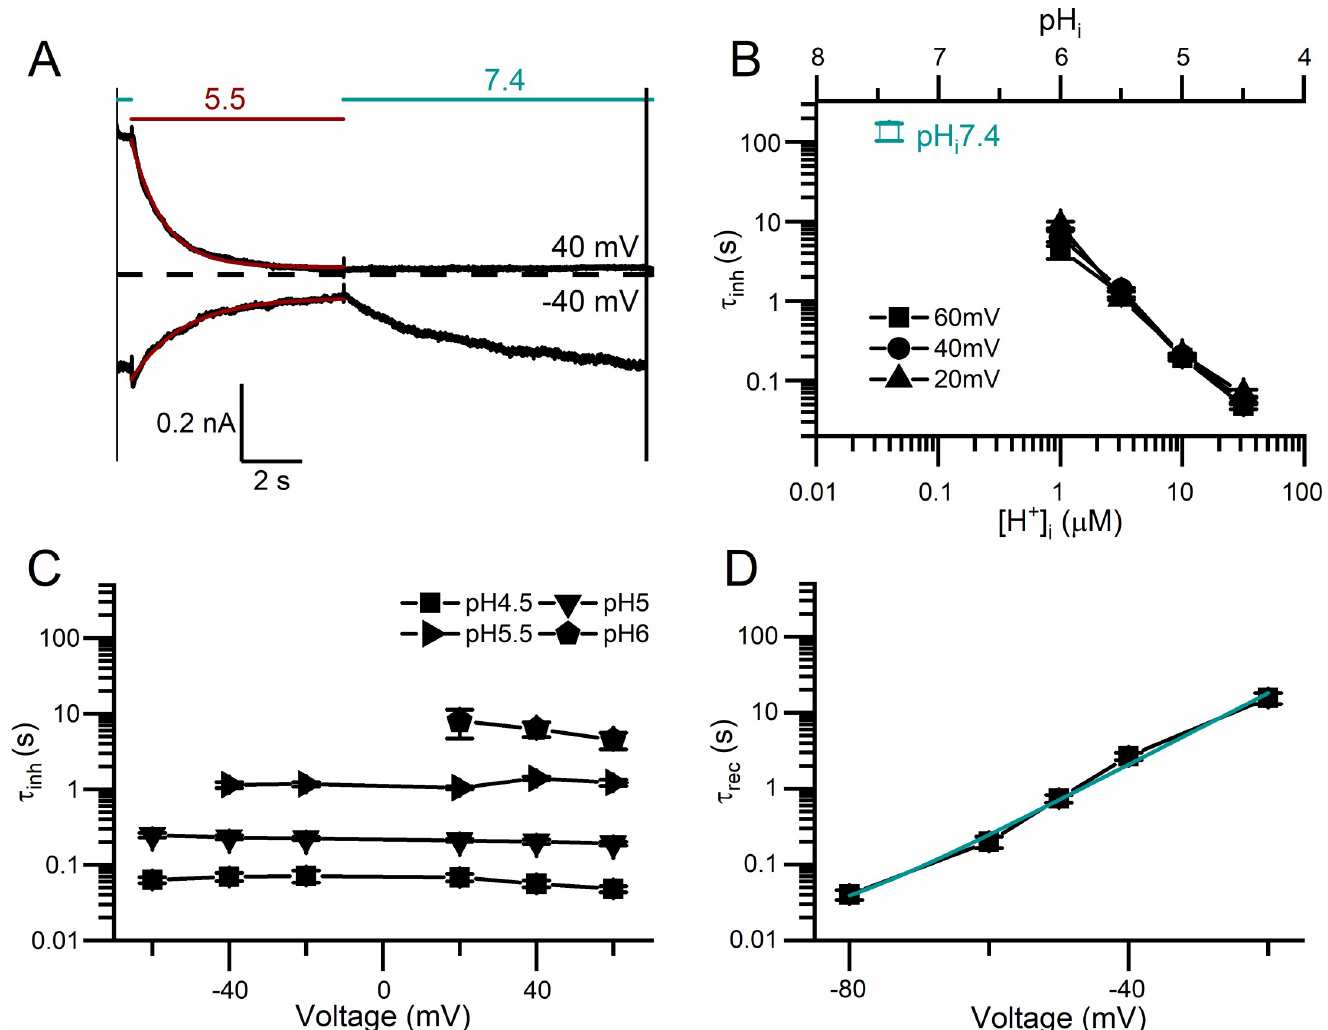
Fig 5. Kinetic analyses of current inhibition and recovery of the H + -induced WT CLC-0 inhibition. Experiments were performed with protocol III on excised inside-out patches. Voltages were held constant throughout the recording sweep during which the intracellular solutions with different pH were switched. (A) Current inhibition and recovery at ± 40 mV. The numbers above the dashed horizontal lines (red and sea green colors) indicate the values of pH i . Fitted exponential decay curves (red) are superimposed with the recording traces in black. (B) Time constants of inhibition at three voltages ( τ inh ) plotted against [H + ] i (or pH i ). The time constant of the slow-gate closure at pH i = 7.4 at room temperature (measured separately) is shown by open square in sea green color (n = 5–8). (C) Voltage dependence of the inhibition time constant ( τ inh ) (n = 5–9). (D) Current recovery time constants ( τ rec ) against membrane voltages (n = 6).